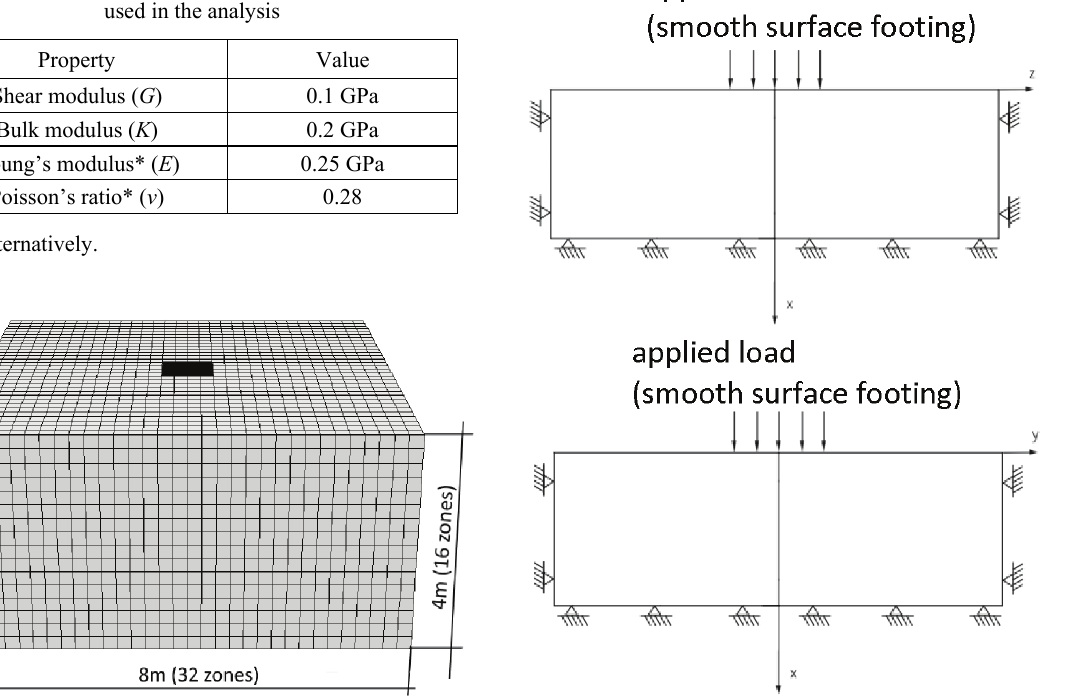
Fig. 3. Discretization of the problem domain and assumed boundary